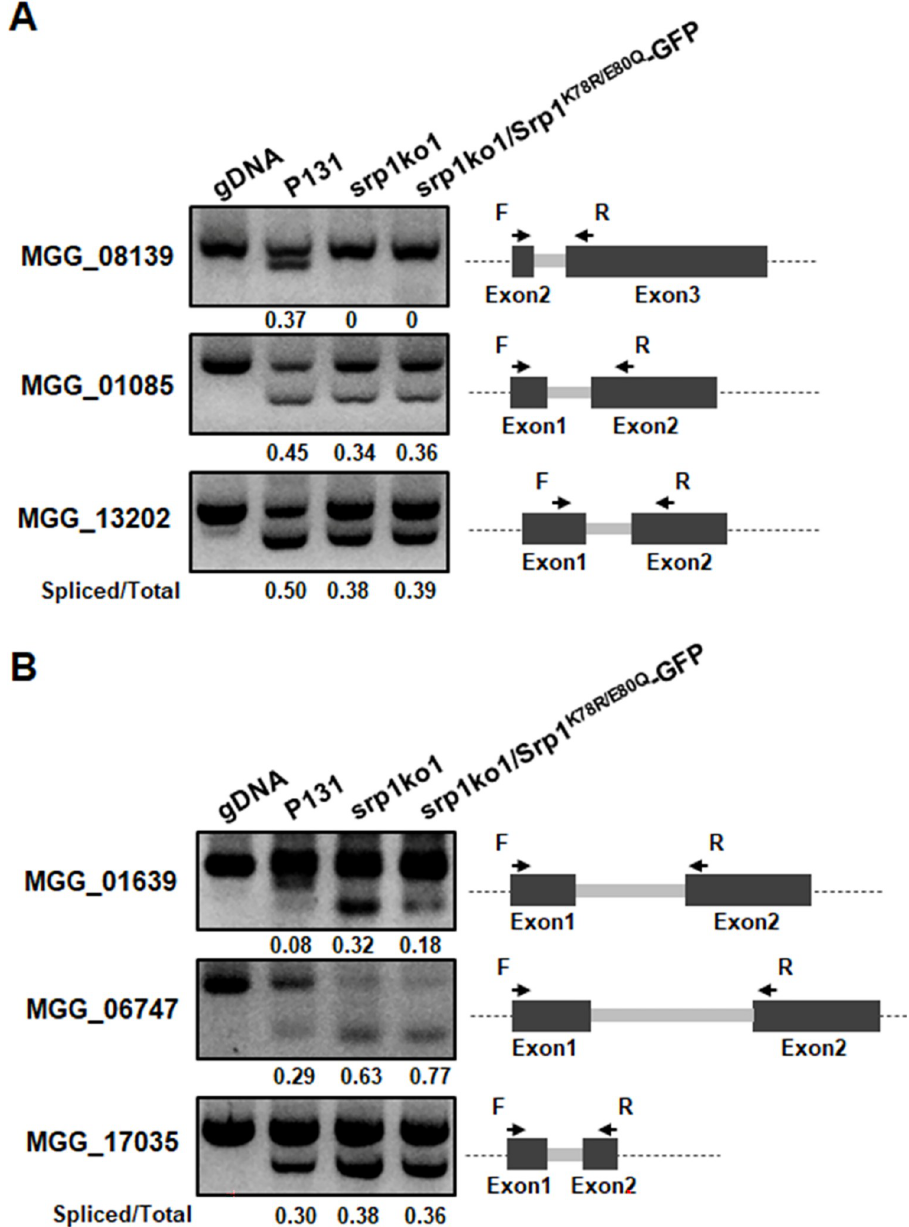
Fig 4. MoSrp1 regulates intron splicing efficiency. RT-PCR analyses show (A) enhanced splicing efficiencyand (B) suppressed splicing efficiency of three introns in the wild-type P131, the Δ Mosrp1 mutant srp1ko1, and its complementation transformant cSRP1 K78R/E80Q expressing the mutated sumoylation site (srp1ko1/Srp1 K78R/E80Q -GFP) allele. The corresponding genomic DNA (gDNA) fragment amplified was used as a control with the un-spliced intron. The ratio between the spliced and the total introns was shown at the bottom of each